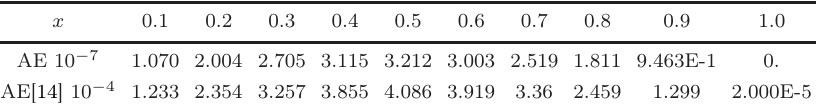
Table 1. Absolute errors for example 1. AE denote absolute error in our method; AE [14] denote absolute error in [14].